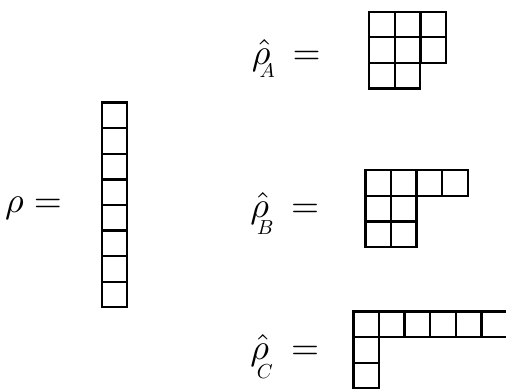
Figure 1 . Three theories ( A; B; C ) with the same (cid:26) and di(cid:11)erent ^ (cid:26) . These theories admit the same (cid:0) (cid:1) continuous global symmetry SU(8) (cid:2) U(2) (cid:2) U(1) = U(1) but di(cid:11)erent (cid:12)ne print. The gravitational dual solutions all consist of one stack of N = 8 D5-branes and two stacks of ^ N 1 = 2 and ^ N 2 = 1 NS5-branes, but they di(cid:11)er in the distribution of the 8 units of D3-brane charge. (cid:12)rst k rows of the right diagram, for all k = 1 ; (cid:1) (cid:1) (cid:1) ; ^ p (cid:0) 1. 1 In the dual linear-quiver